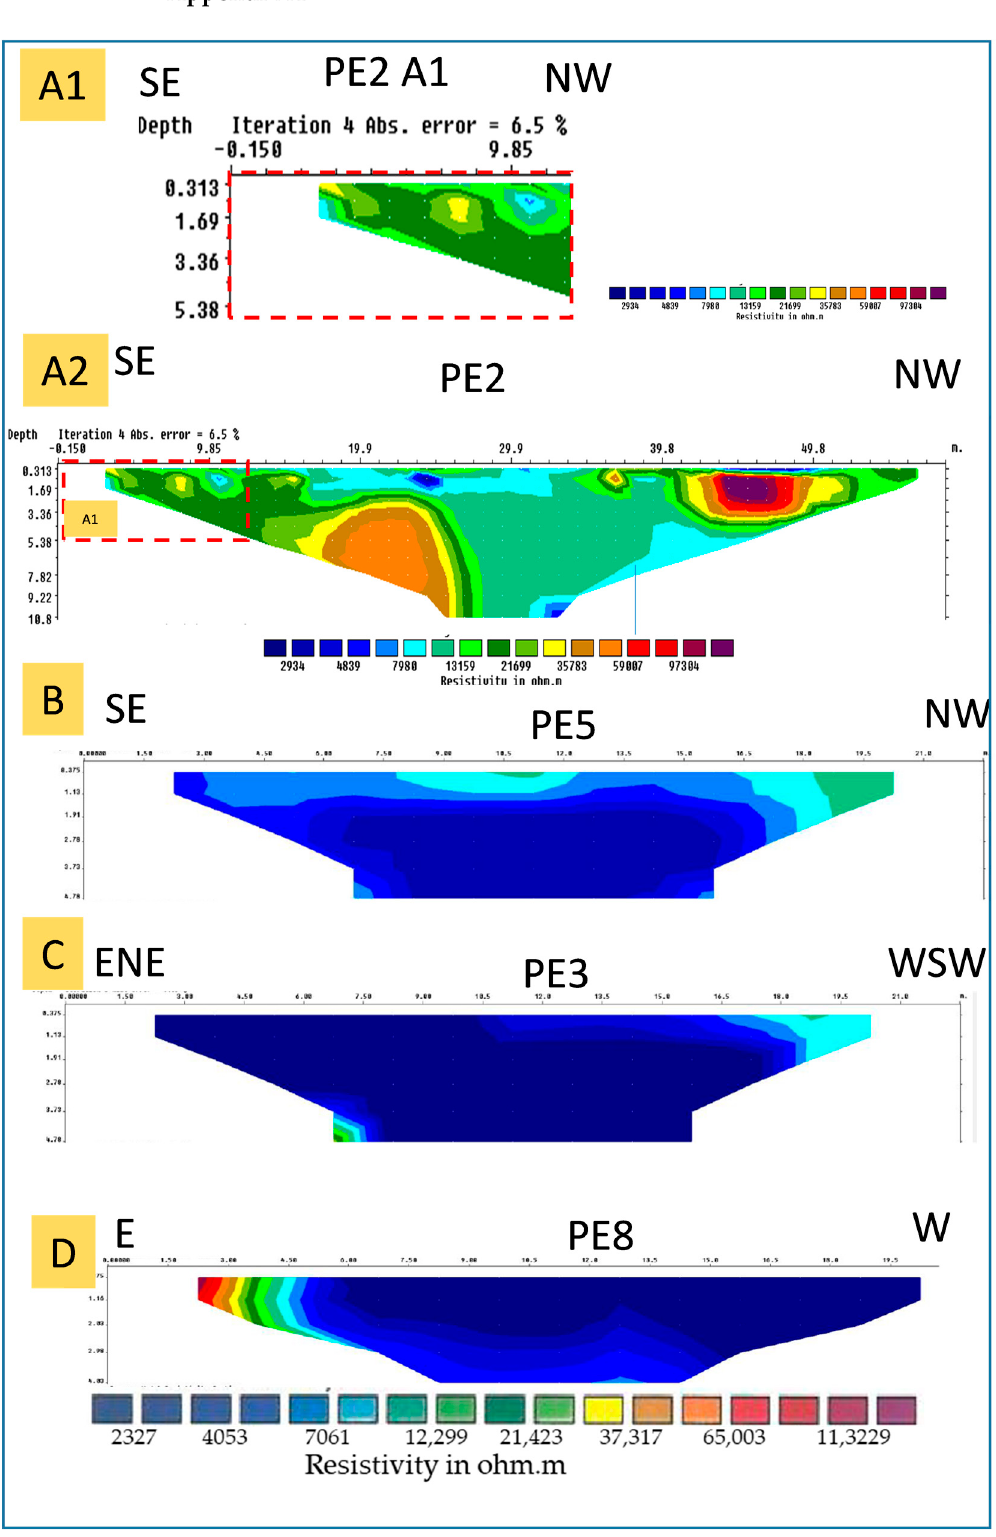
Figure A1. True electrical resistivity profiles (ERT) transverse to the valley axis. ( A1 ) Profile PE2, which corresponds to the magnified image of the SE part of profile PE2 at the same scale as profile PE5 for easy comparison and interpretation. ( A2 ) Profile PE2; ( B ) Profile PE5; ( C ) Profile PE3; ( D ) Profile PE8. For location, look at Figure